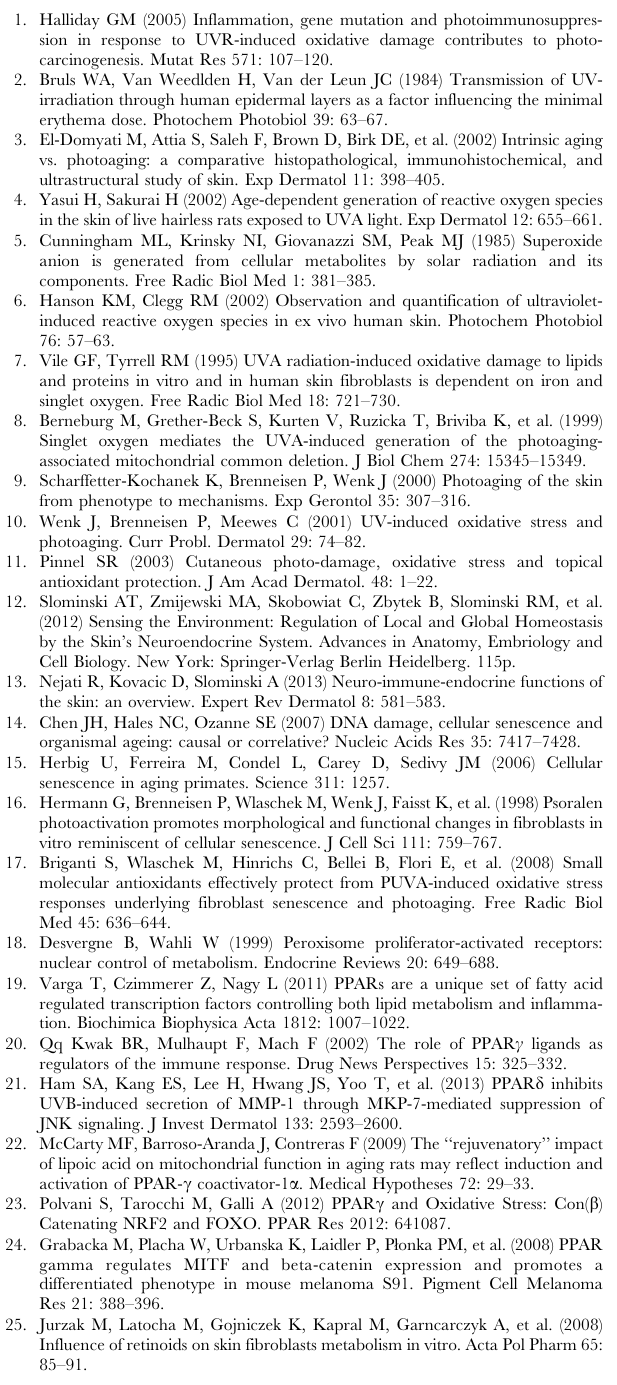
Table S1 List of primers used for quantitative real time PCR. Sequences of primers indicated with an F correspond to sense strands and with an R correspond to